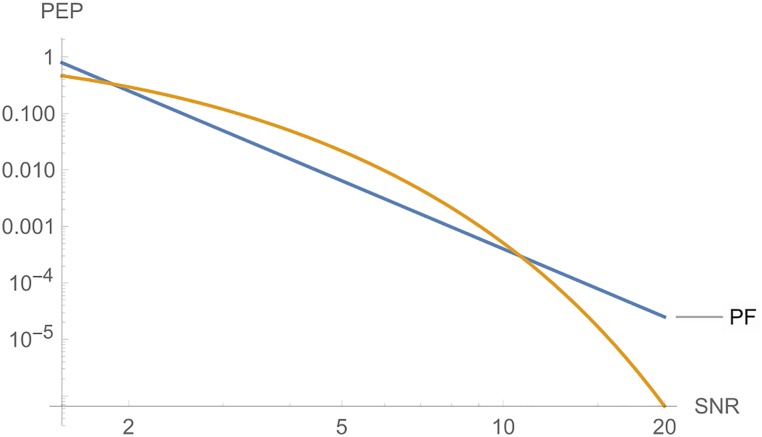
Graphs of PE, PF and PT for Example 2, where nT = nR = l = 2, and SNR is a function of Es.